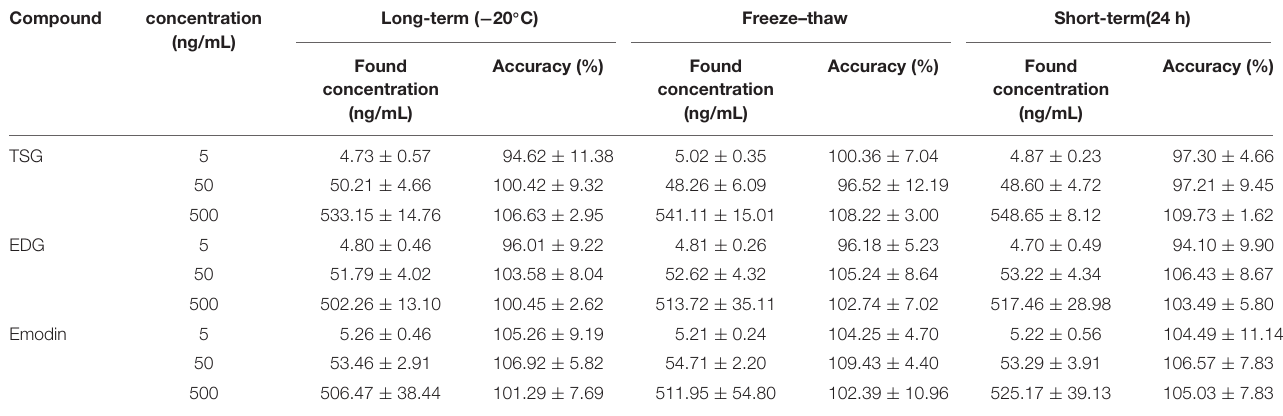
TABLE 5 | Stability of TSG, EDG, and emodin under various storage conditions. Compound concentration (ng/mL)